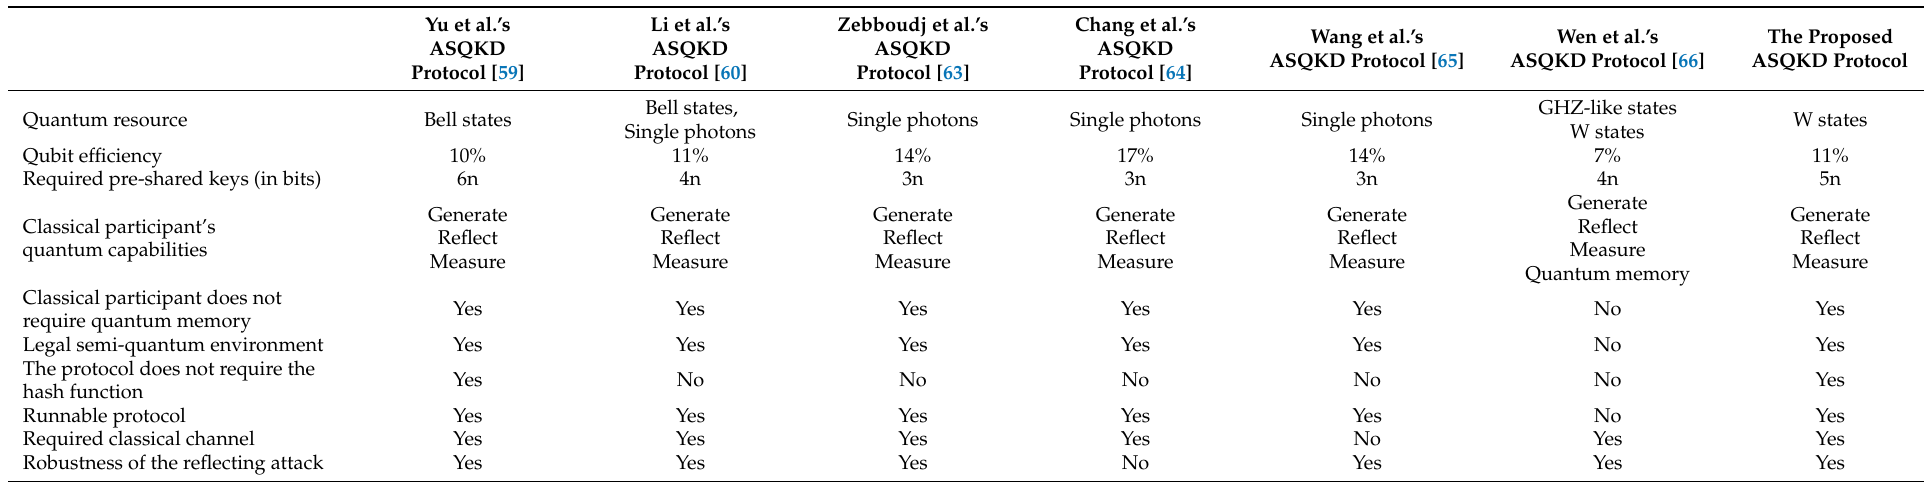
Table 3. Comparison of [59,60,63–66] and the proposed ASQKD